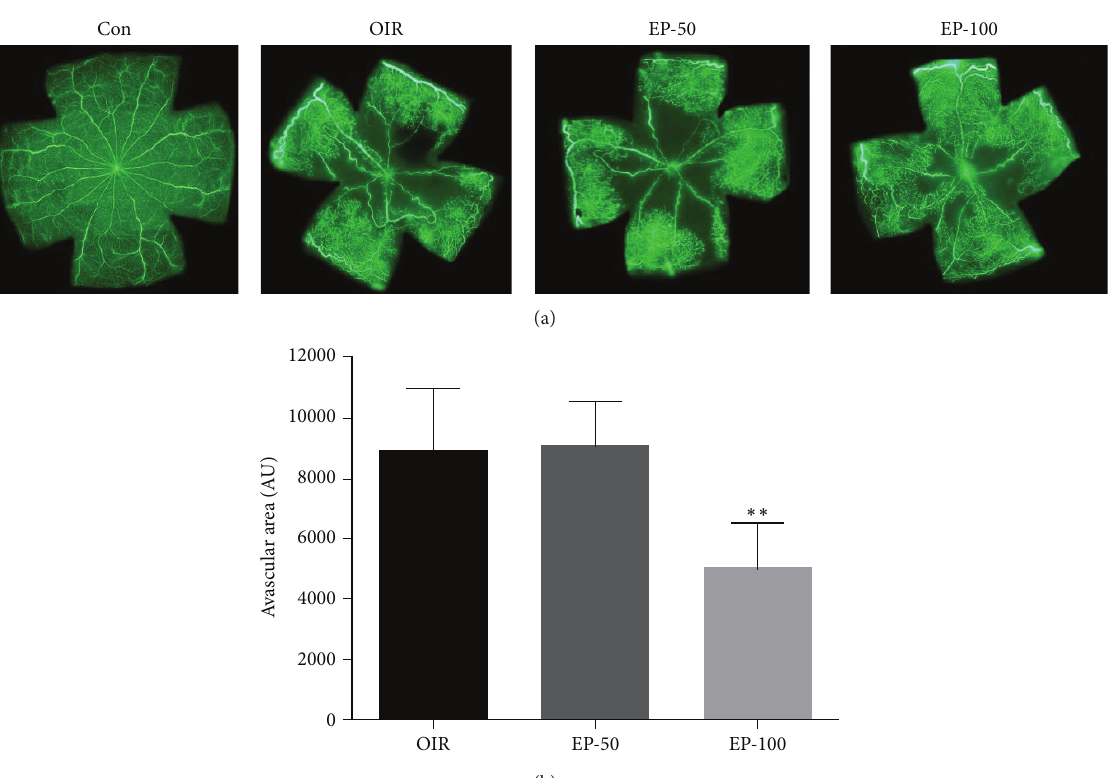
Figure 1: The effect of EP on retinal neovascularization in OIR mice. (a) The retinal vasculature was determined by fluorescein angiography using FITC-dextran. Whole mount retinal preparation from P17 control (Con), OIR (OIR), 50mg/kg EP-treated (EP-50), and 100mg/kg EP-treated (EP-100) mice. (b) Quantitative analyses revealed that EP treatment significantly reduced the area of neovascularization in retinas compared with OIR. The data are expressed as the mean ± SE (𝑛 = 4) . ∗∗ 𝑃 < 0.01 versus the OIR